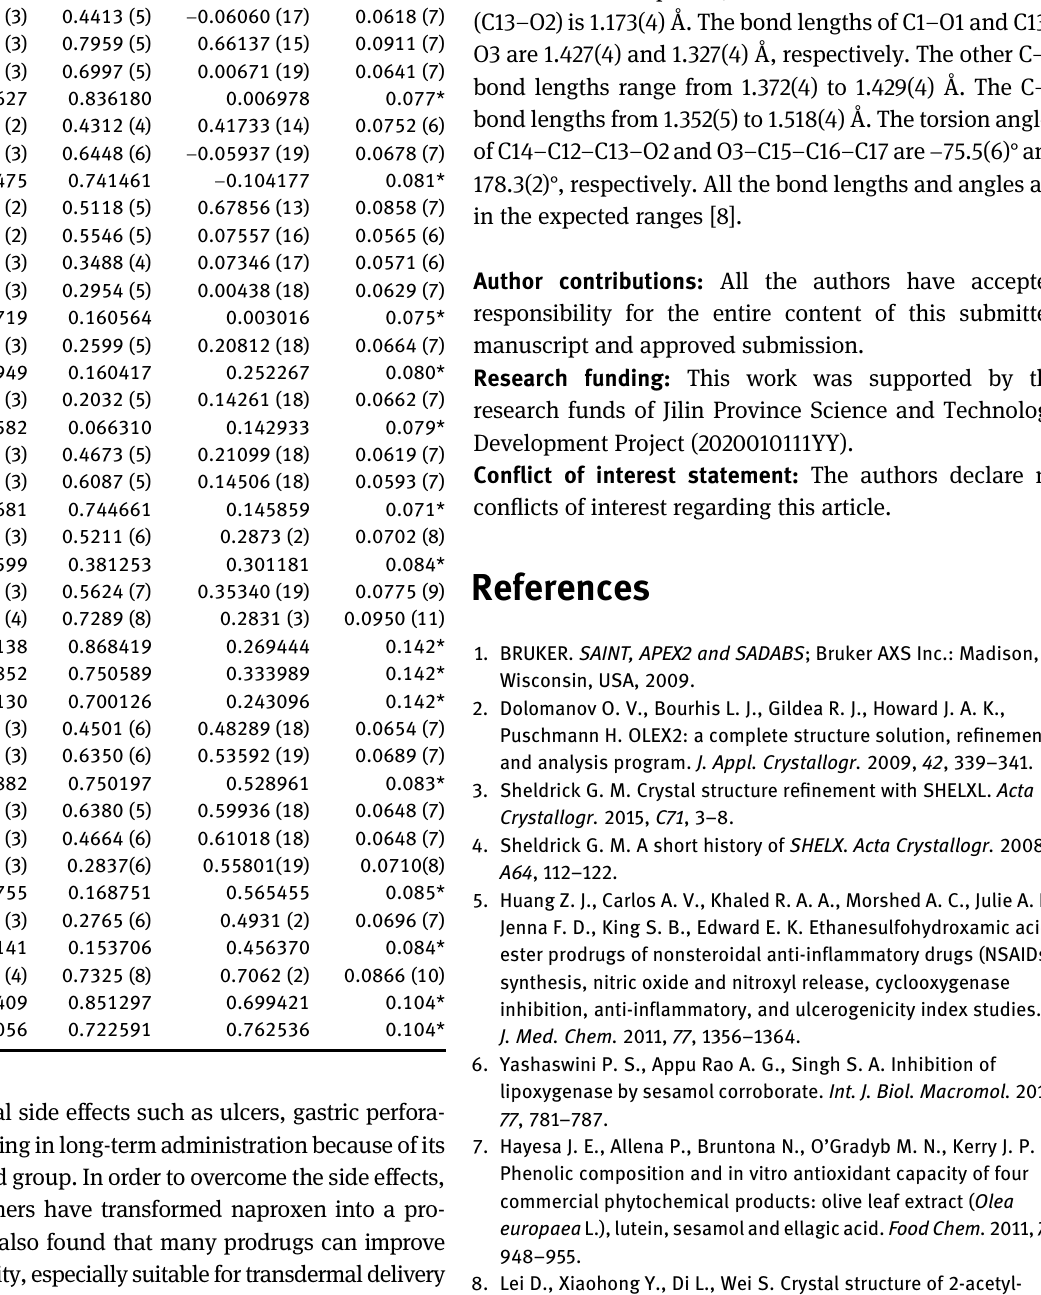
as a prodrug based on the combination principles. We expect to reduce the side effects of naproxen and improve its bioavailability.